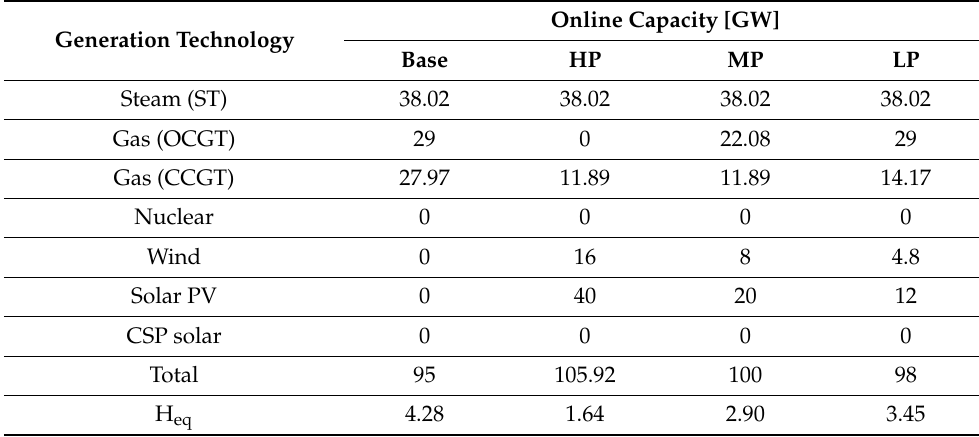
Table 8. Online generation capacity under base load conditions in 2030.